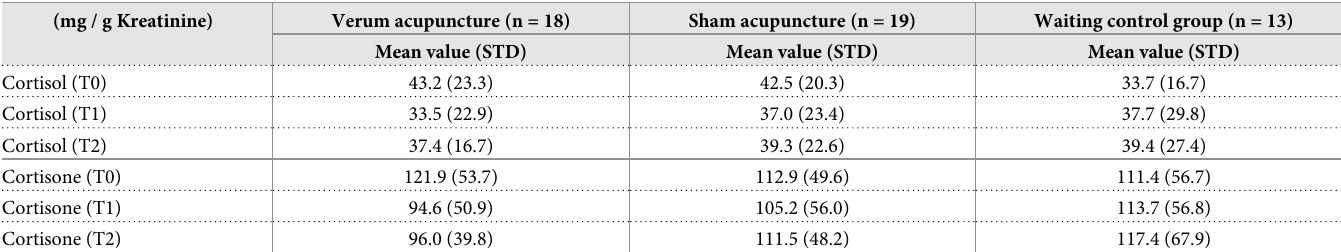
Table 5. Mean values of cortisol and cortisone measured in urine samples at baseline, T1, and T2. (mg / g Kreatinine) Verum acupuncture (n =